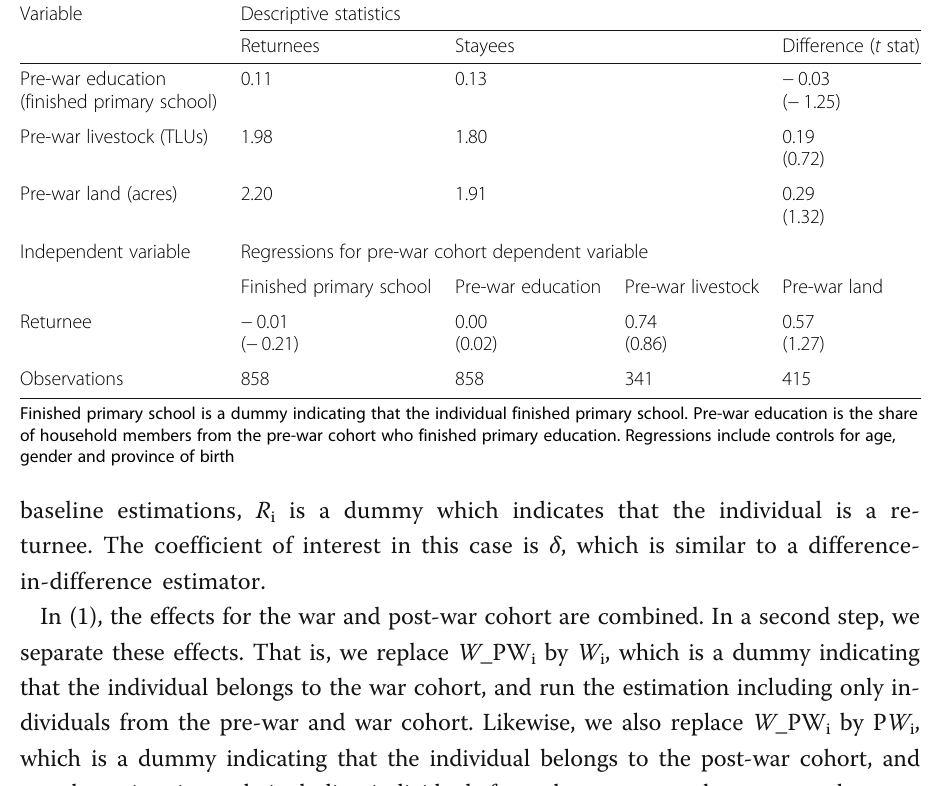
Table 2 Descriptive statistics and regressions of pre-war indicators Variable Descriptive statistics